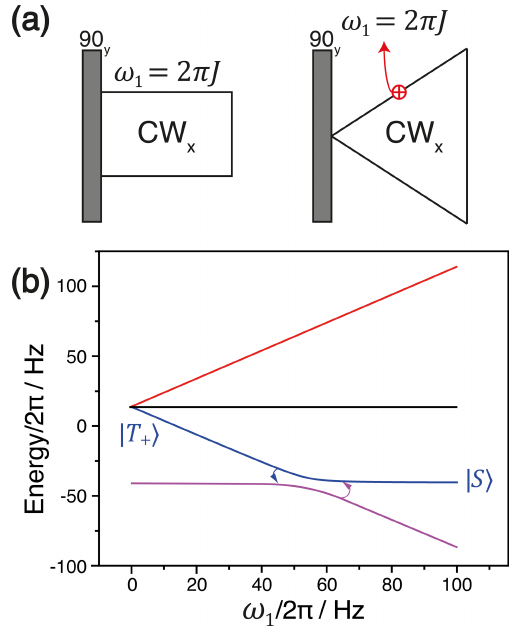
Figure 7. (a) The experimental protocol of SLIC (left) and adia- batic SLIC with linearly ramped RF-field amplitude (right). (b) Cor- relation diagram describing T + → S conversion at the